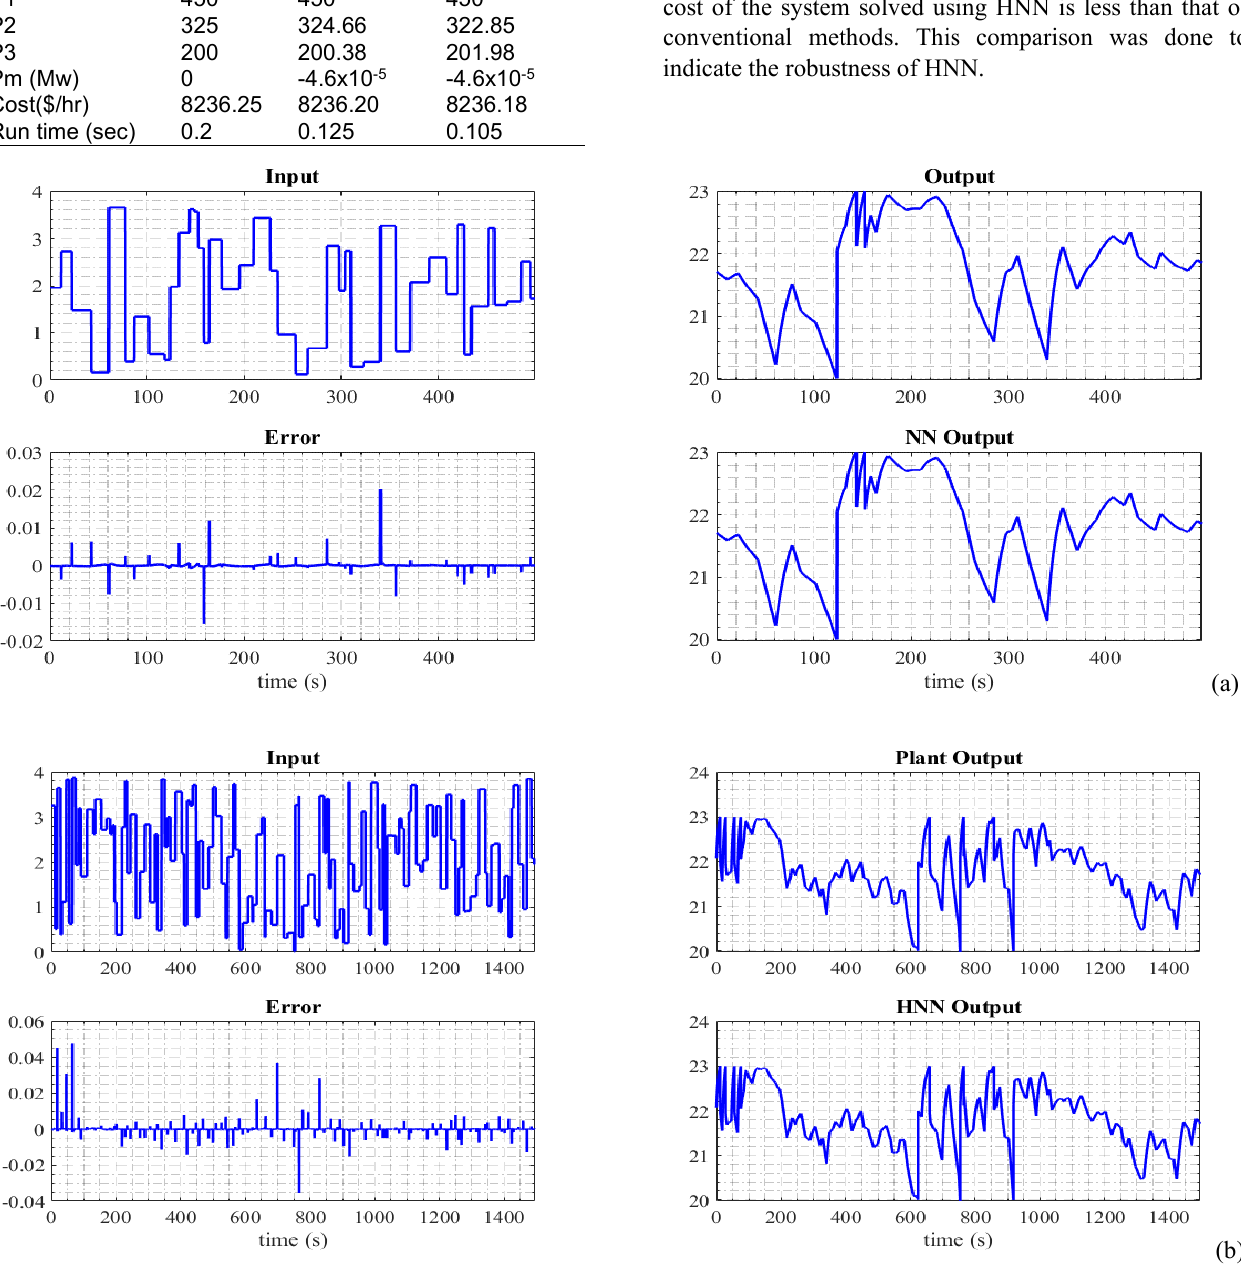
Figure 2. Predictive control of variable renewable energy resources using neural networks for the NREL-118 test system (a) and Ethiopian renewable energy systems